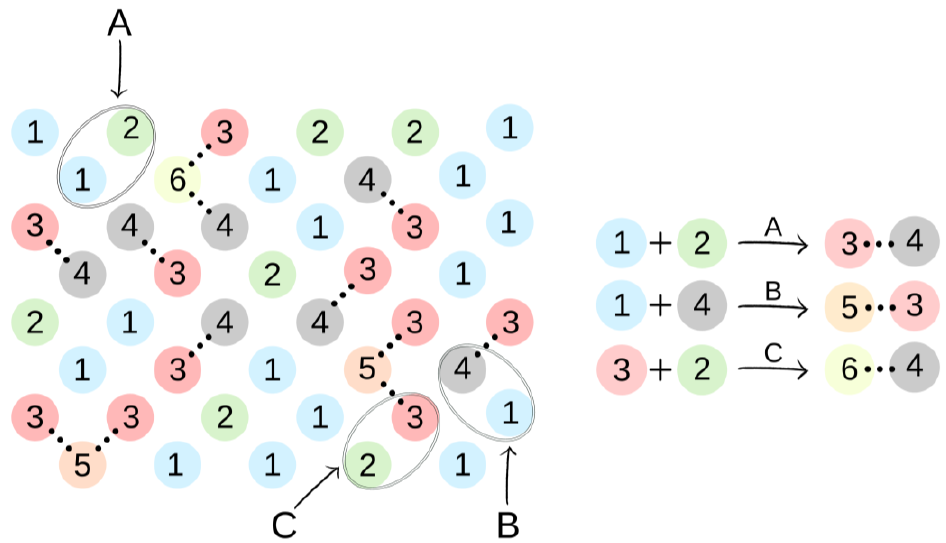
Figure 3. An illustration of the simulation of the synthesis of BMC. The colors and numbers correspond to the objects from Figure 2. The chemical bonds formed in reactions A–C are marked by dotted lines.